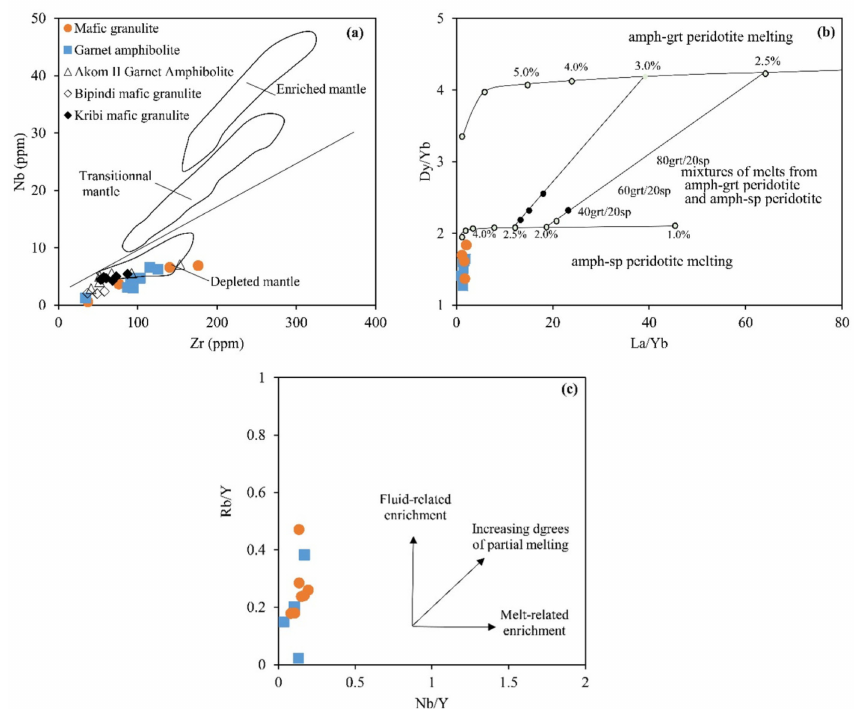
Figure 14. Binary plots for magma source characteristics of the Anyouzok metavolcanic rocks: ( a ) Zr vs. Nb [75]; ( b ) La/Yb vs. Dy/Yb [73]; ( c ) Rb/Y vs. Nb/Y